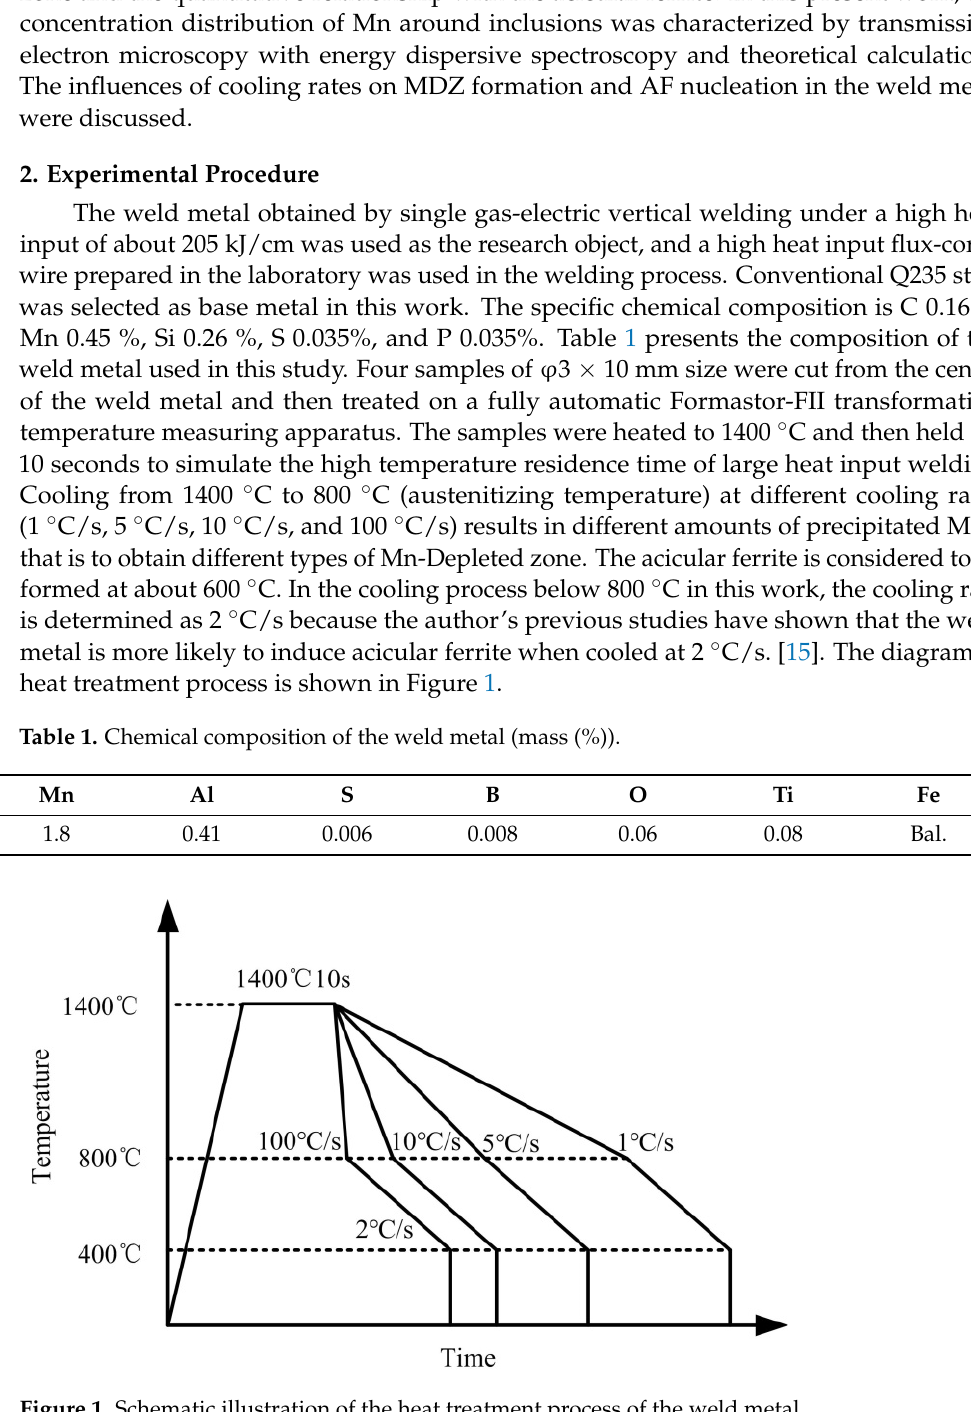
Figure 1. Schematic illustration of the heat treatment process of the weld metal. The heat-treated samples were cut by wire cutting, fixed by phenolic resin, and then ground and polished by sandpaper. A 3% (volume fraction) nital (4 mL of HNO 3 + 96 mL of C 2 H 5 OH) was used to etch the samples. The metallographic microstructures of the samples near the thermocouple were detected by a LEICA Q5501W Microscope